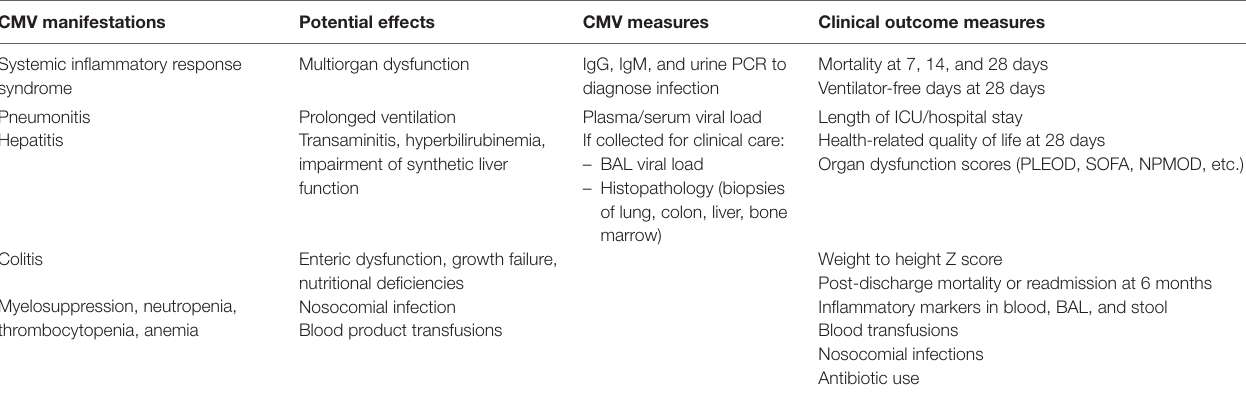
tAbLe 1 | Suggested metrics for studies of cytomegalovirus (CMV) viremia in immunocompetent pediatric intensive care unit (ICU) patients. cMv